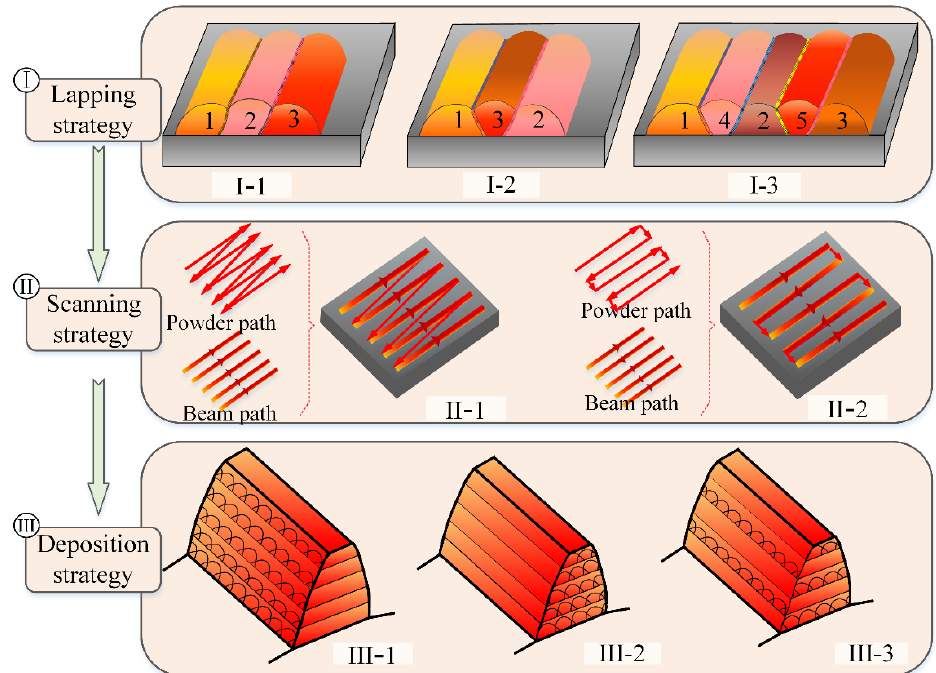
Figure 5. Deposition strategies’ optimization of the gear tooth: (I-1) hot lap joint, (I-2) cold lap joint, (I-3) optimized cold strategy, (II-1) co-directional scanning, (II-2) reverse scanning, (III-1) interlayer scanning perpendicular to the axial direction, (III-2) interlayer scanning parallel to the axial direction, (III-3) scanning directions of the two adjacent layers are perpendicular to each other.